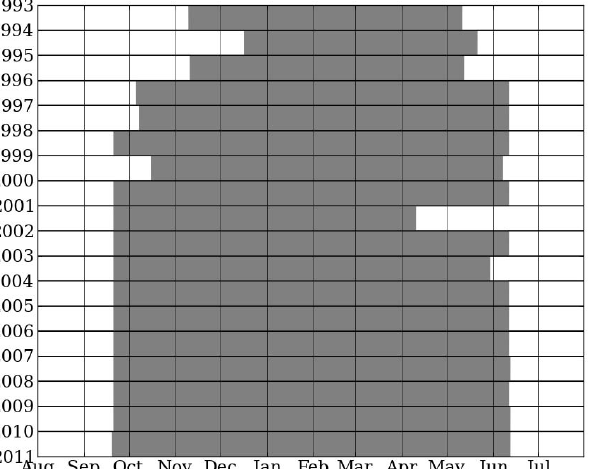
Figure 4. Summary of the partitioning between in-situ data (grey) and the output of the meteorological downscaling tool SAFRAN (white) used to build the gap-free driving